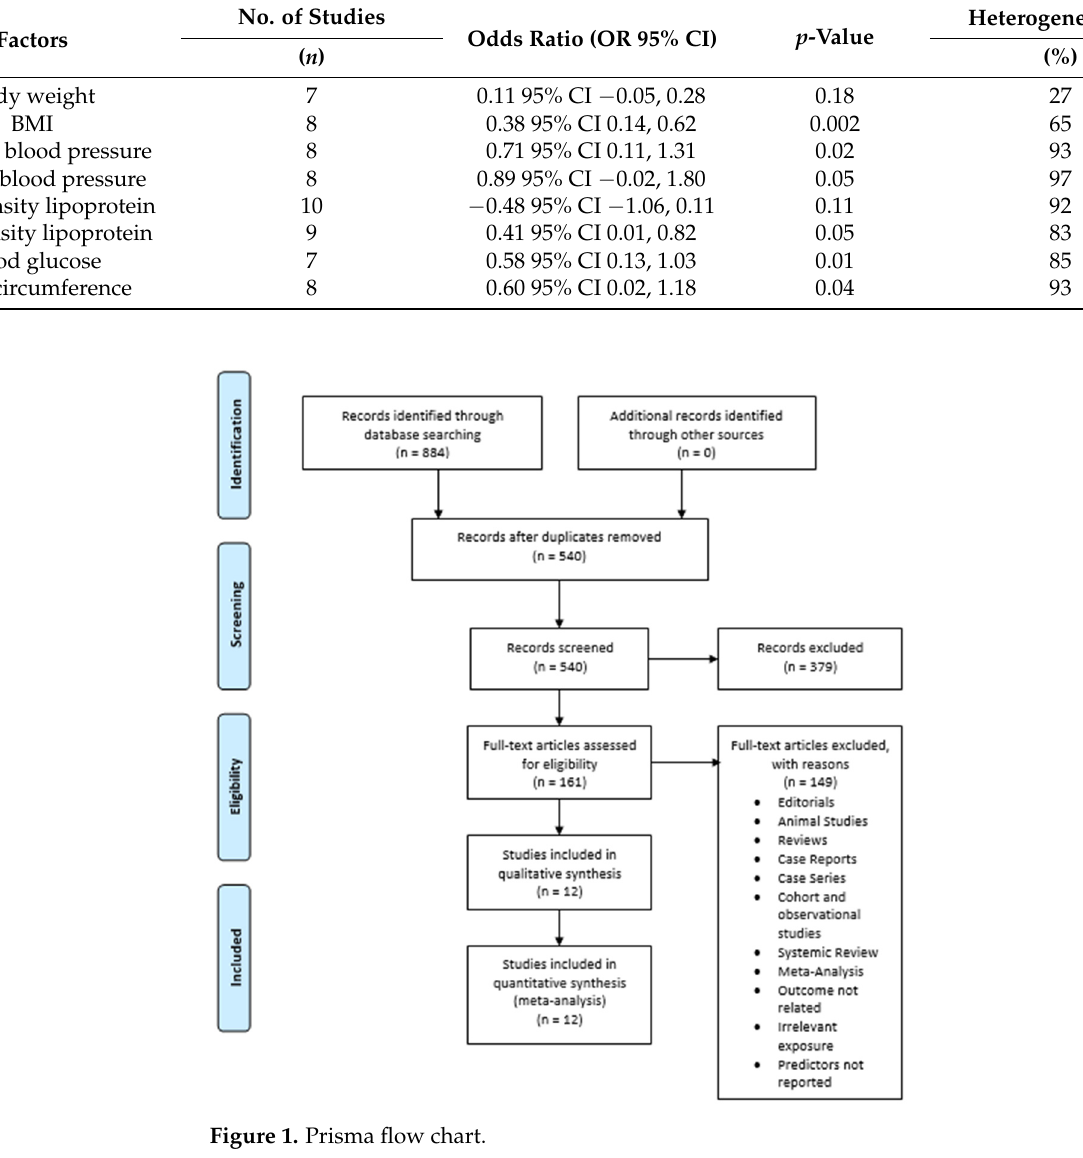
Table 3 . Characteristics of the included studies.